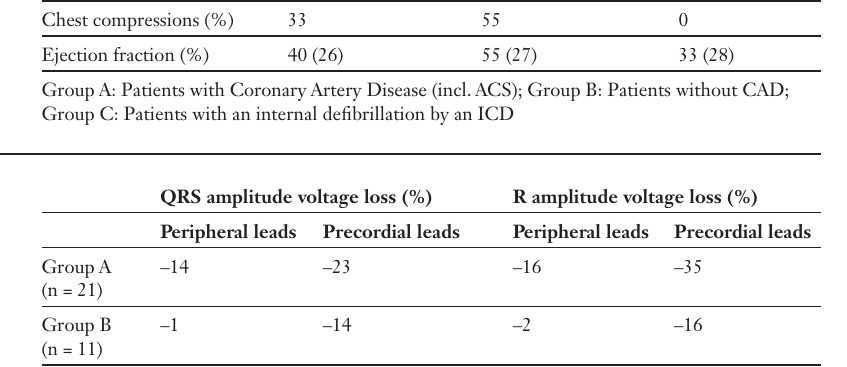
Baseline characteris- tics of patients with external (Group A and B) and internal (Group C) defibrilla- tion/cardioversion. Median values with IQR (in brackets).